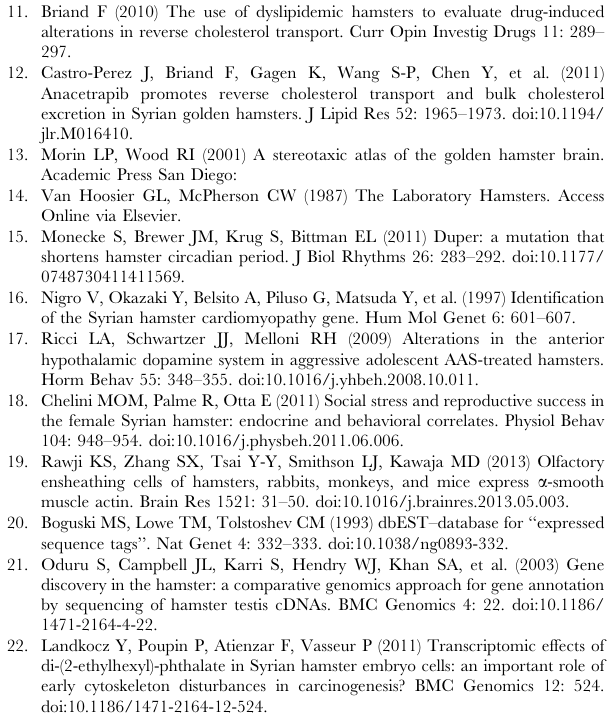
Figure S1. Legend for the IPA canonical pathways representations. Figure showing the annotations of the different node and edge shapes in the representations of the canonical pathways obtained from Ingenuity Pathway Analysis (IPA). Table S1 List of highly-covered transcripts by the Syrian hamster transcriptome. Table showing the 214 highly-covered transcripts (transcripts mapped at least at 90% by the contigs and singletons) based on the mouse annotations. For